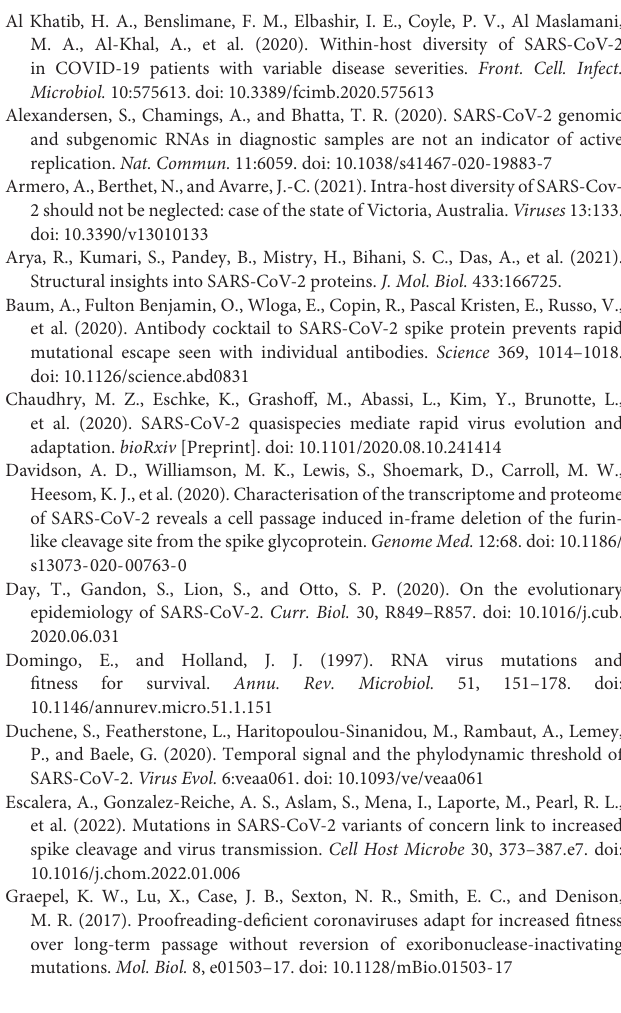
Supplementary Figure 1 | COVID-19 cohorts and sampling timeline. (A) Representation of the initial patient pool considered for this study. Patients excluded (grey) and their respective samples (yellow circle) did not pass quality filtering. The pink and light blue blocks represent the severe and mild cohorts respectively. Within cohorts, the blue silhouettes represent longitudinally sampled patients and green represents patients where only one sample was taken. The number of longitudinal samples included in the study are indicated but the numerical values below the silhouette. The number of samples in the cohort that failed quality filtering are illustrated by the black cross. (B) The cohort type and duration of onset days of enrolled patients. Samples of patients with known symptom onset (green circle) and unknown symptom onset (green triangle) are illustrated. When more than one sample was taken on the same day, the shape is outlined in black. Severe and mild cases are shaded with red and blue, respectively. Patients infected with SARS-CoV-2 Delta lineage are represented by grey vertical bars. Patients within the same genomic epi-cluster are grouped by purple (Lineage B.1.617.2, cluster NSW 130), yellow (Lineage D.2, cluster NSW 33.1), orange (Lineage D.2, cluster NSW 33), and green (Lineage B.1, cluster NSW 17.5) shaded boxes. Black diamonds denote household contacts within the genomic epi-cluster. Supplementary Figure 2 | Boxplots depicting the SARS-CoV-2 copy number (A) and median genome depth (B) for all cohorts. The bold line indicates the median,